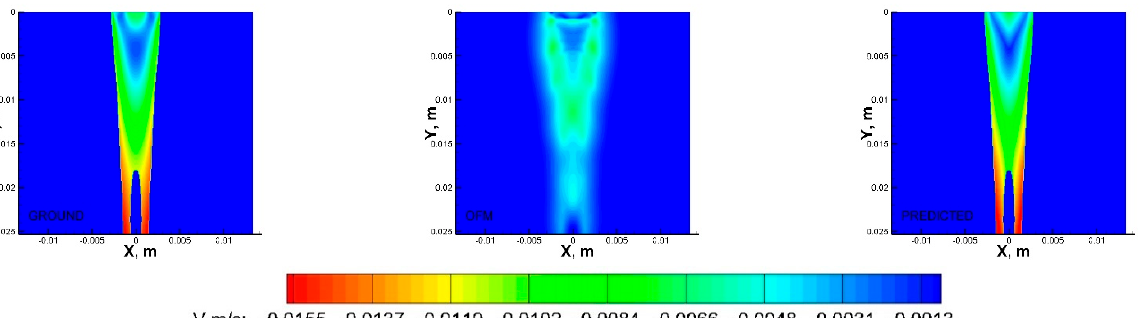
Figure 8. V − contours of the CFD ground truth ( left ), OFM ( middle ), and predicted ( right )